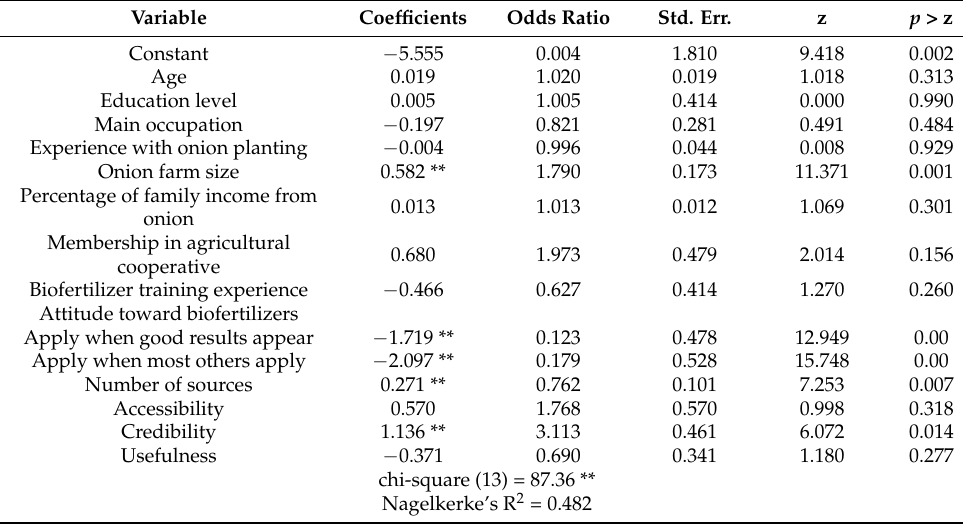
Table 6. Factors influencing adoption of